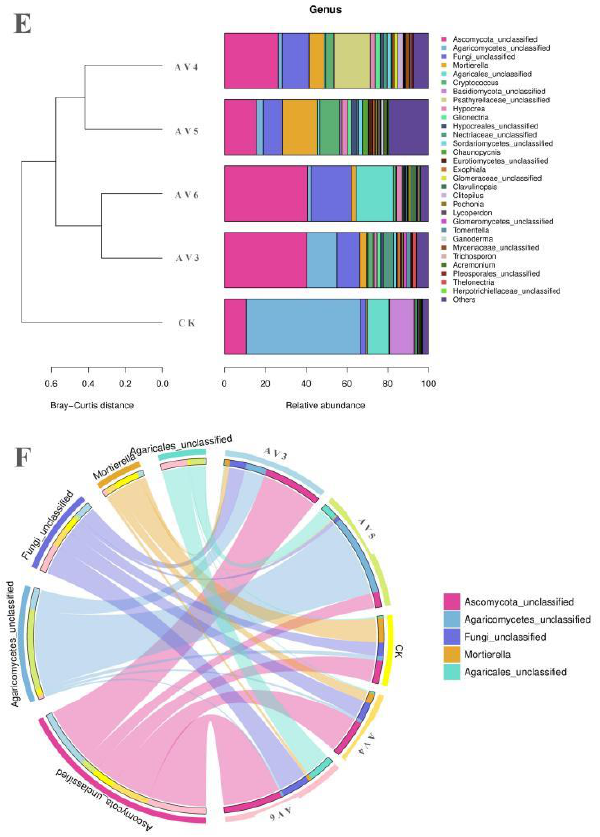
Figure 3. Fungal composition and community structure in A. villosum rhizosphere soils and a fallow field. ( A ) Bar plot of the fungal community at the phylum level. ( B ) Circos plot of the top five fungal communities at the phylum level. ( C ) Bar plot of the fungal community at the class level. ( D ) Circos plot of the top five fungal communities at the class level. ( E ) Bar plot of the fungal community at the genus level. ( F ) Circos plot of the top five fungal communities at the genus level. The relative abundance in each sample was calculated on the basis of the percentage of the total effective fungal sequences, which were classified using the SILVA databank. Phyla, classes, and genera representing less than 1% of the total composition in both libraries were classified as ‘other.’ AV3, AV4, AV5, and AV6 represent the rhizosphere soil samples from the fields in which A. villosum was continuously cropped for 3, 4, 5, and 6 years, respectively, whereas CK represents the soil sample from the fallow field.